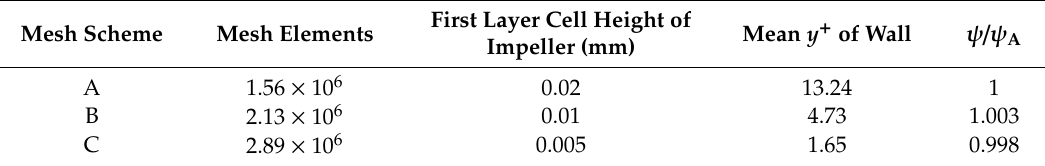
Table 2. Mesh independence verification of the axial-flow fan.